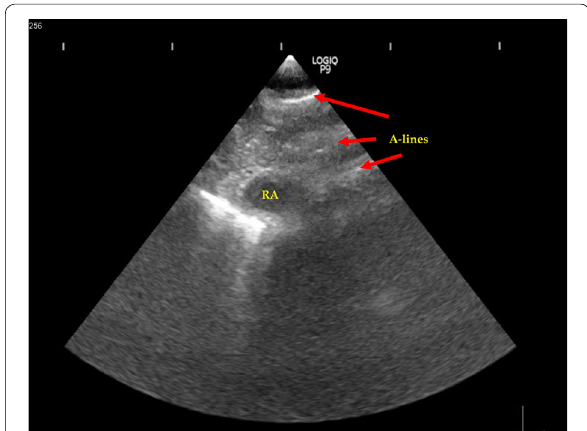
Fig. 1 Subxiphoid view showing visible A-lines indicating the presence of air (red arrow)